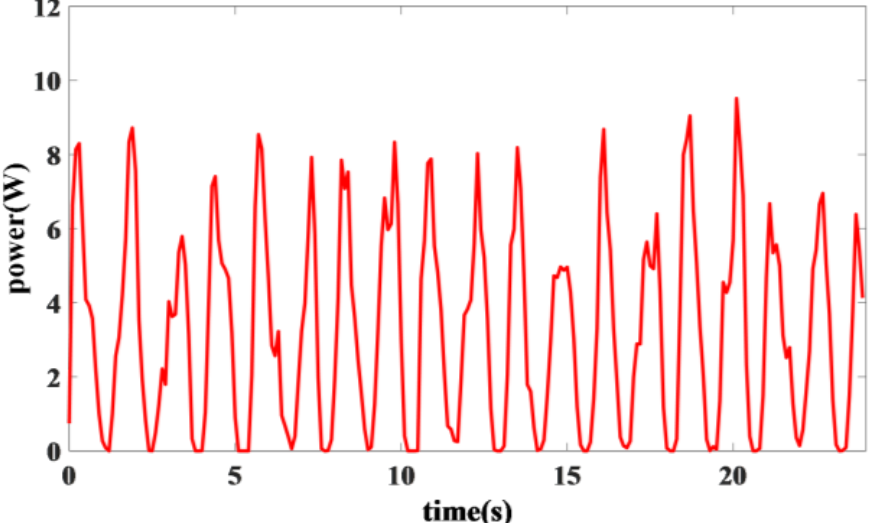
Figure 5. The output power time history curve when the electromagnetic switch valve is always in the open state.